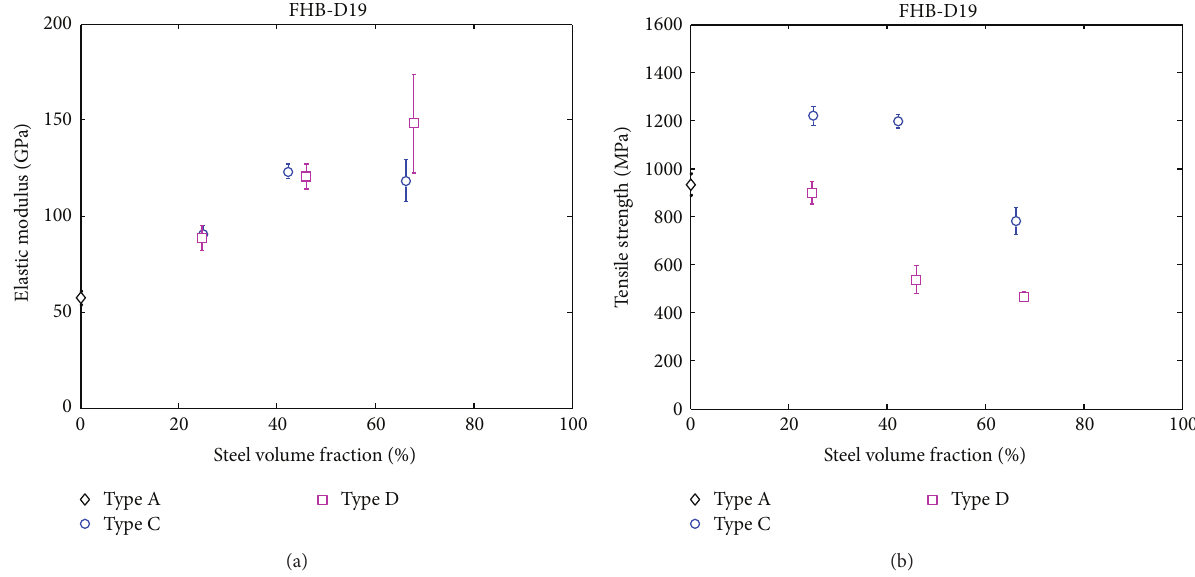
Figure 17: Test results for D19 FRP Hybrid Bar: (a) elastic modulus; (b) tensile strength.